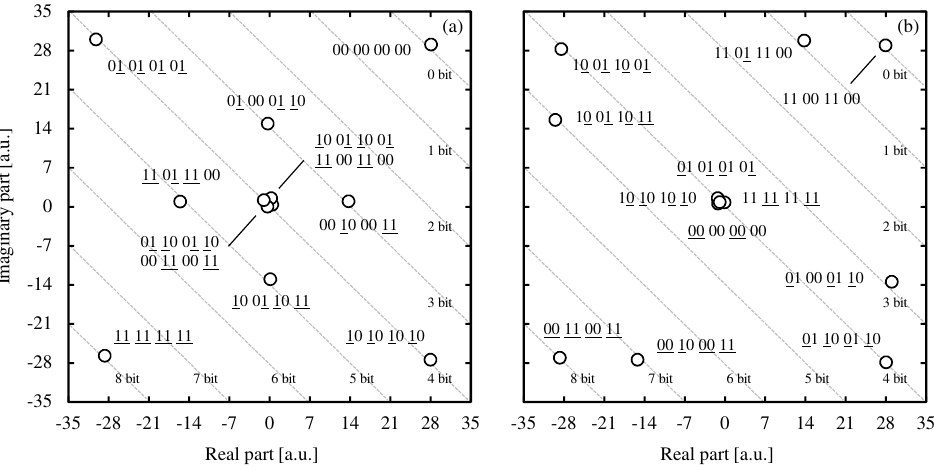
Figure 5. Constellations of the 8-bit optical comparator: ( a ) “00 00 00 00” comparator. ( b ) “11 00 11 00” comparator. In these figures, all constellations are located in conformity with the Hamming distance based on the comparator codes “00 00 00 00” and “11 00 11 00”, respectively. The inconsistent bits with the comparator code are underlined in each comparator.